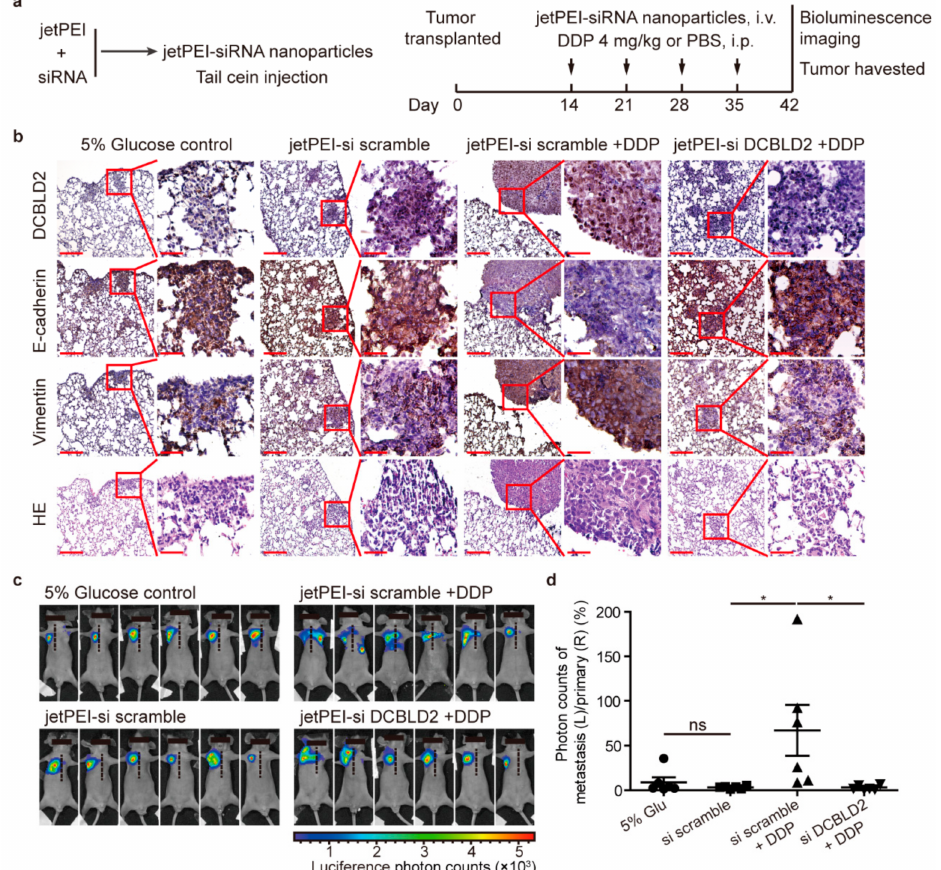
Figure 7. jetPEI nanocarrier-delivered anti-DCBLD2 siRNAs significantly inhibit tumor metastasis in a resistant LUAD mouse model. ( a ) jetPEI nanocarrier was used as the vehicle for DCBLD2-targeted siRNAs to inhibit DCBLD2 expression in vivo. Schematic of the nanoparticles (left panel); the timeline of drug administration (right panel). Pc9/cis-luciferase cells were orthotopically transplanted into nude mice to develop tumors ( n = 6 for each group). Fourteen days after inoculation, jetPEI- nanoparticles containing scramble or DCBLD2-targeted siRNA were intravenously injected. Mice injected with 5% glucose served as a negative control group. Mice were intraperitoneally injected with 4.0 mg/kg cisplatin or an equivalent volume of PBS every 7 days. ( b ) The primary tumors in the right lung and the metastatic foci in the left lung were serially sectioned and then subjected to HE staining. The expression of DCBLD2, E-cadherin, and Vimentin was detected by IHC staining. Scale bar: 200 µ m (left), 50 µ m (right). ( c , d ) Bioluminescence imaging ( c ) was performed to detect metastasis, and quantitation of bioluminescence signals is shown in ( d ). * p < 0.05, t -test. DDP, refers to cis-diamminedichloridoplatinum (II), also known as cisplatin or